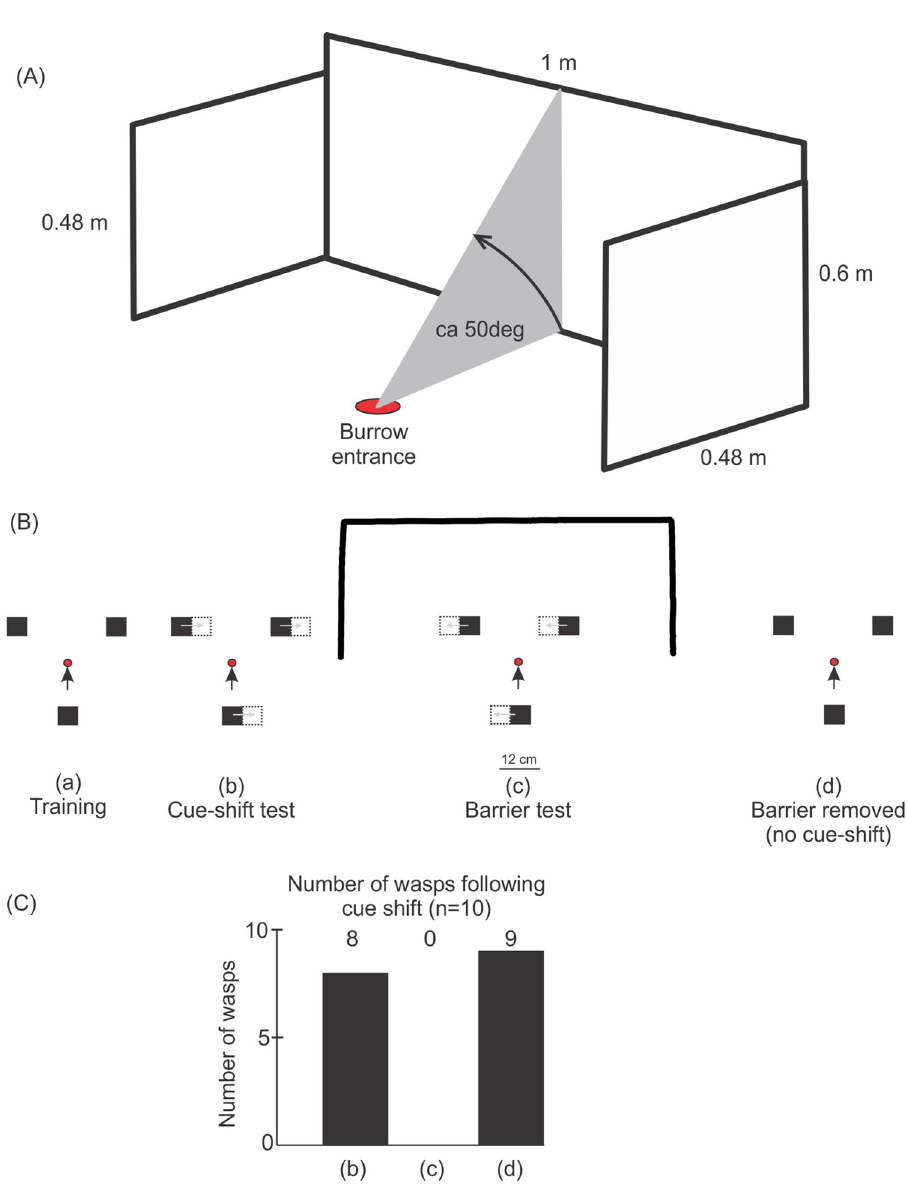
Fig 5. The interaction between local and distant cues. Ten wasps were trained on a configuration of three 3 cm 3 wooden cubes placed around their burrows. (A) Position and measurements of the opaque barrier. (B) (a) training to configuration (black squares) around burrow, (b) sideways configuration-shift to the right (white squares) to test learning by wasp, (c) introduction of barrier along with shift of configuration to left of original configuration position, (d) barrier removed (configuration not shifted), black arrows indicate direction wasps face. (C) The number of wasps responding to the shift of the landmark configuration by digging attempts or by hovering at the center of the landmark array in condition (b), (c), and (d) (see (B) above). None of the wasps followed the configuration in